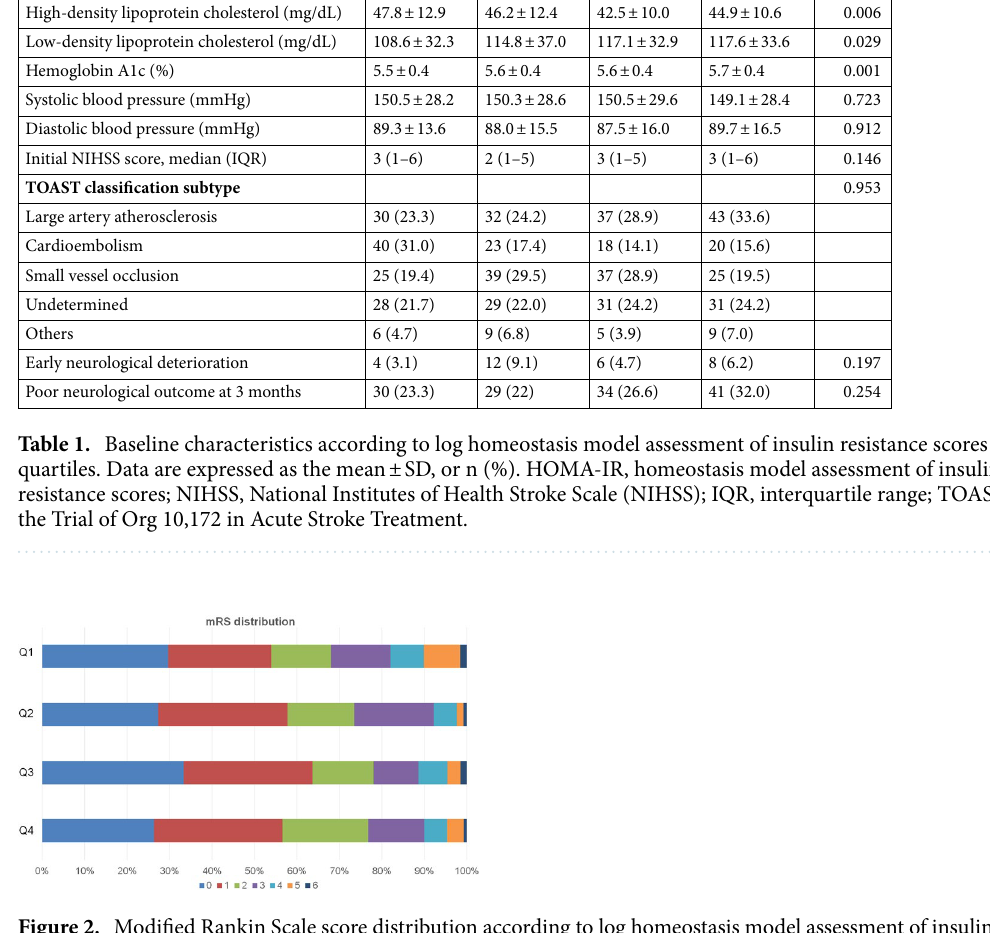
Figure 2. Modified Rankin Scale score distribution according to log homeostasis model assessment of insulin resistance score quartiles. Modified Rankin Scale score distribution shows higher score distributions in the highest quartile of log homeostasis model assessment of insulin resistance